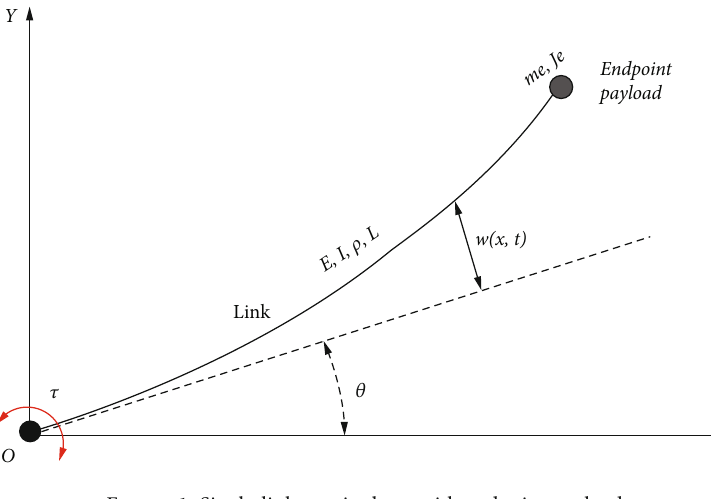
Figure 1: Single-link manipulator with endpoint